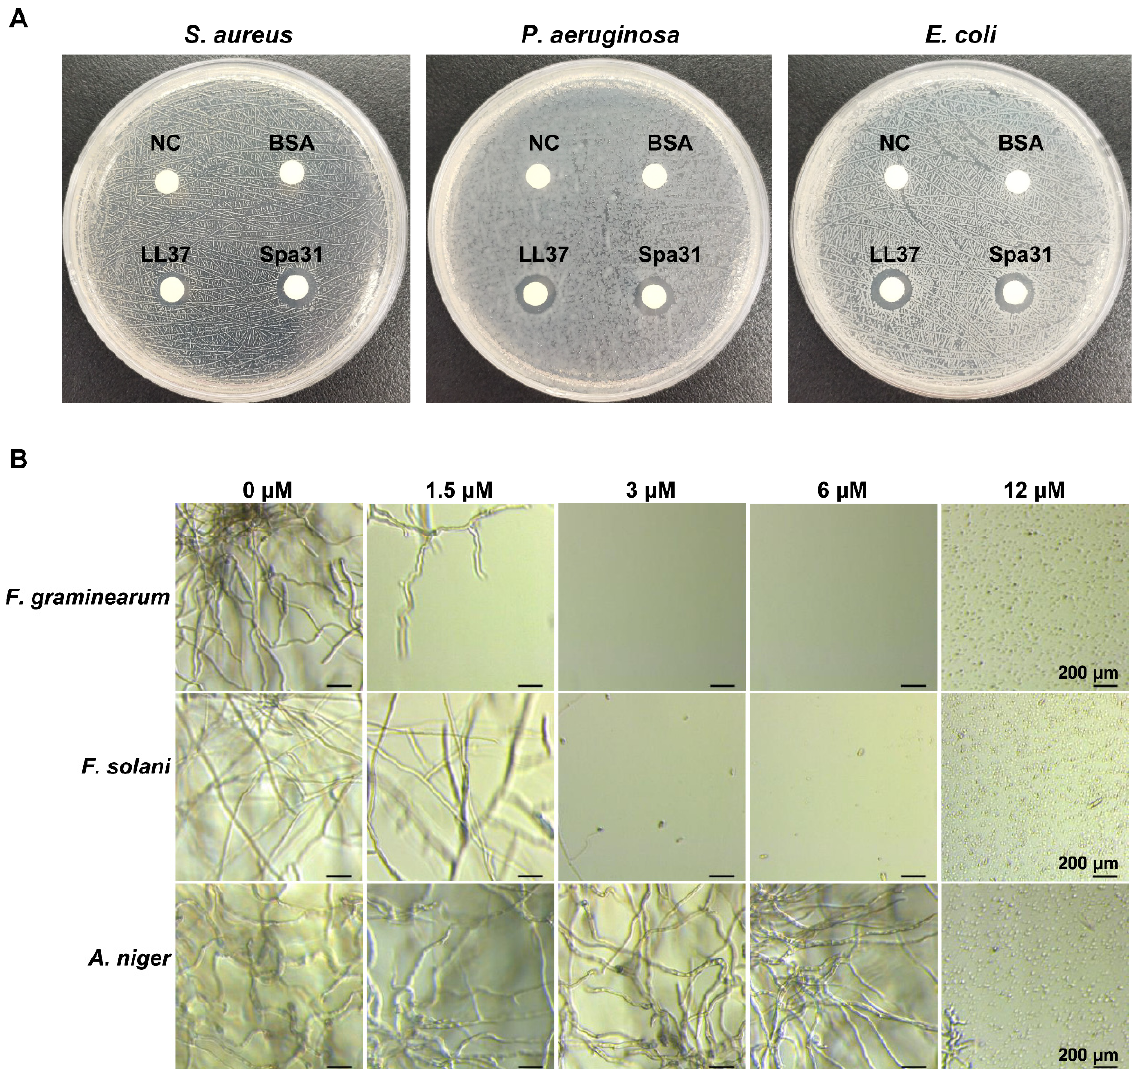
Figure 2. Inhibitory effect of Spa31 treatment on bacterial and fungal spore germination. ( A ) Zone of inhibition against bacteria (including S. aureus , P. aeruginosa , and E. coli ) after treatment with 20 μ L of Spa31, LL-37, or BSA at a concentration of 1 μ g/ μ L. NC represented the negative control group treated with Milli-Q water. ( B ) Effects of Spa31 on spore germination of F. graminearum , F. solani , and Aspergillus niger at different concentrations (1.5, 3, 6, and 12 μ M).